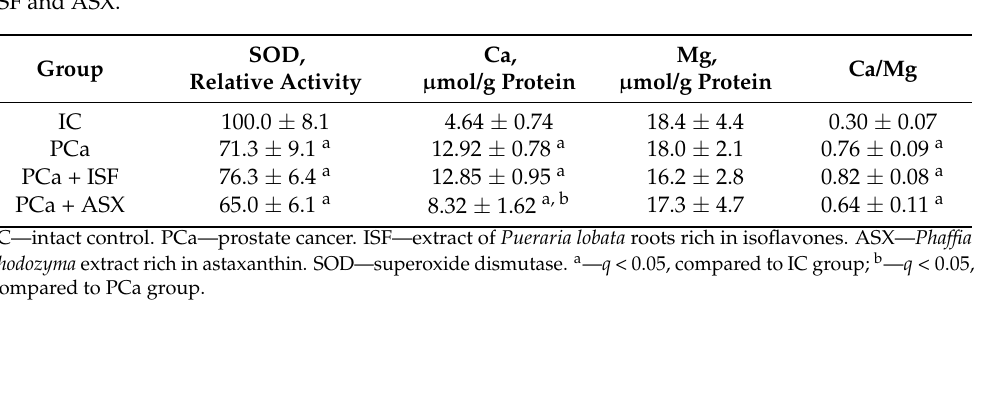
Figure 3. Immunohistochemical staining assessment of prostate ventral lobe for androgen receptor (AR) and p-Ac-Histone H3. IC—intact control. PCa—prostate cancer. ISF—extract of Pueraria lobata roots rich in isoflavones. ASX— Phaffia rhodozyma extract rich in astaxanthin. ( A )—percent of AR- positive nuclei cells; ( B )—percent of p-Ac-Histone H3-positive nuclei cells; ( C , D )—representative microphotographs of AR and p-Ac-Histone H3 immunohistochemical staining in PCa group, corre- spondingly. Arrows indicate positive nuclei. Table 3. Dorsolateral prostate tissue biochemistry in rats with prostate carcinogenesis treated with ISF and